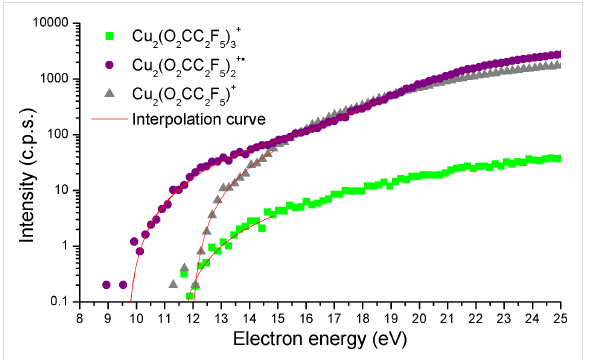
Figure 3: Relative cross sections of the dissociative ionization of the [Cu 2 (µ-O 2 CC 2 F 5 ) 4 ] molecule as a result of a ligand loss fragmentation process. Red lines represent a theoretical fits using the modified Wannier